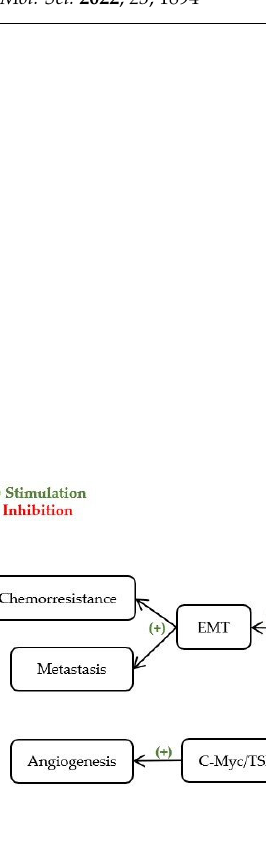
Figure 5. Possible mechanisms underlying morphine’s effects on breast cancer cells. EMT—Epithelial- mesenchymal transition; MOR— µ -opioid receptors; NET-1—Neuroepithelial Cell Transforming 1; PI3K-Akt—Phosphatidylinositol 3-kinase—Protein kinase B; RhoA—Ras homolog family member A; SP—Substance P; TSP-1—Thrombospondin-1.